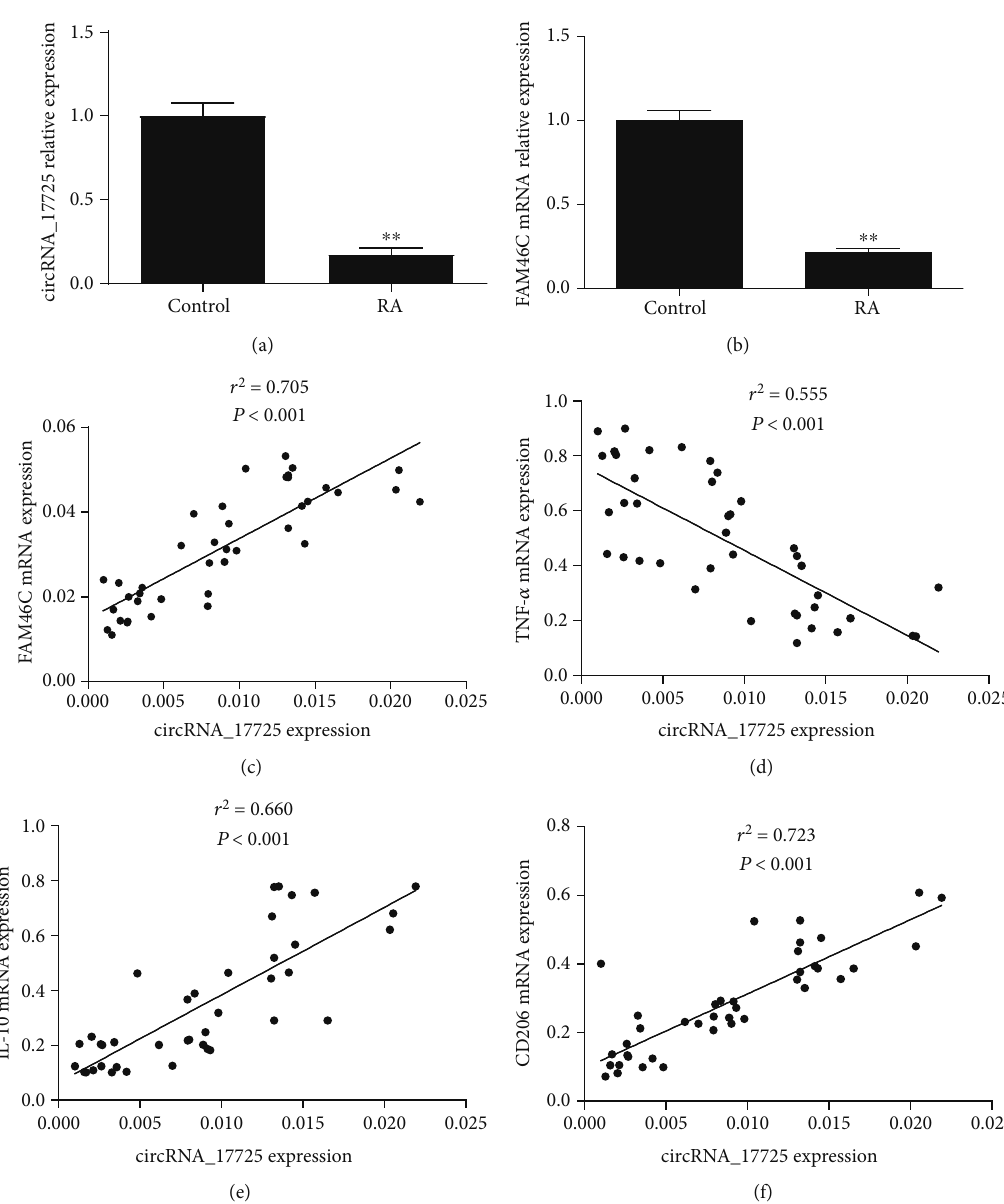
Figure 3: Association between circRNA_17725, FAM46C, TNF- α , IL-10, and CD206 in RA. (a) Expression of circRNA_17725 in CD14 + monocytes from RA patients in contrast to controls ( ∗∗ P < 0 : 01 ; RA/control: 40/30). (b) Expression of FAM46C in CD14 + monocytes from RA patients in contrast to controls ( ∗∗ P < 0 : 01 ; RA/control: 40/30). (c) Pearson ’ s correlation analysis: relationship of circRNA_17725 with FAM46C ( n = 40 ). (d) Pearson ’ s correlation analysis: relationship of circRNA_17725 with TNF- α ( n = 40 ). (e) Pearson ’ s correlation analysis: relationship of circRNA_17725 with IL-10 ( n = 40 ). (f) Pearson ’ s correlation analysis: relationship of circRNA_17725 with CD206 ( n = 40